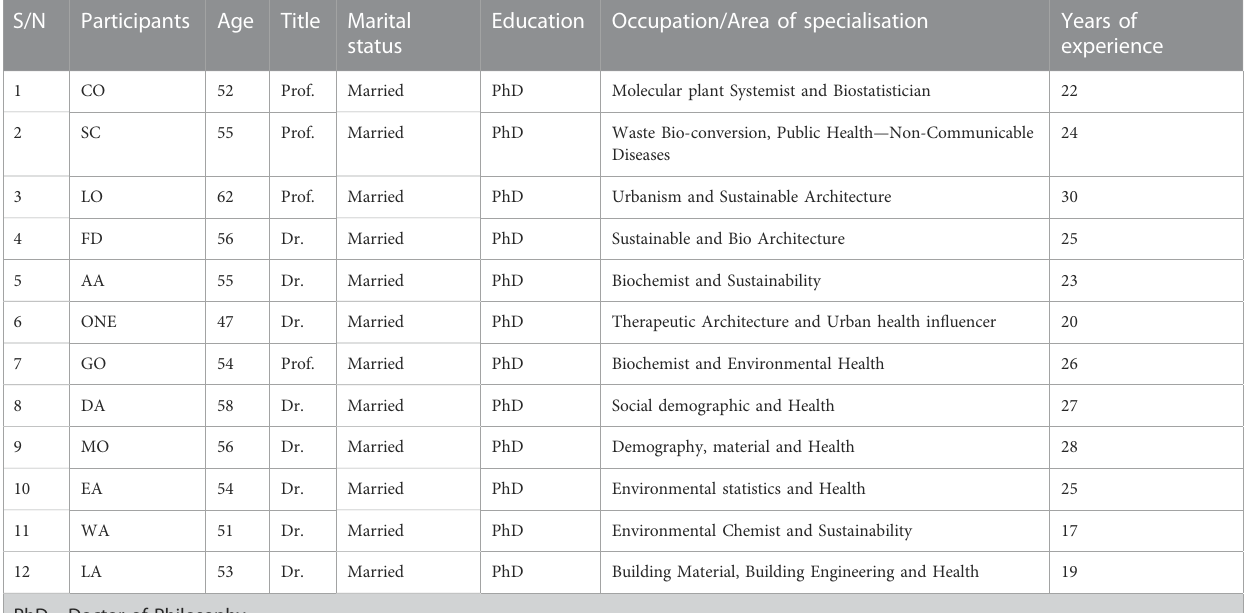
TABLE 1 Demographic information of the participants.